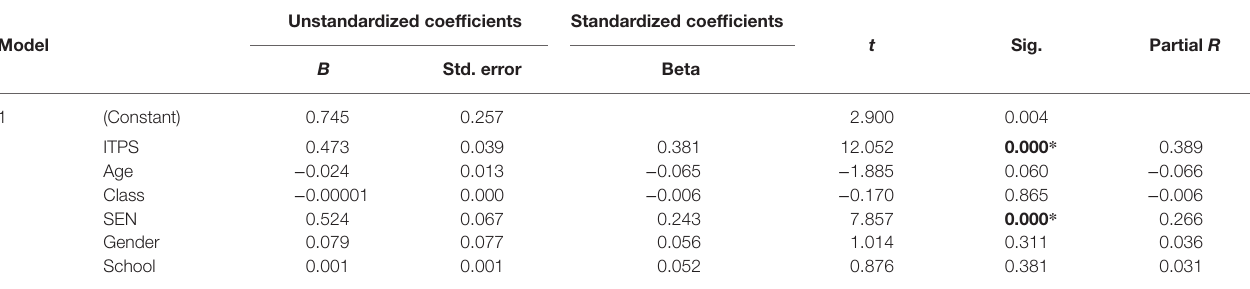
TABLE 5 | Multiple regression statistics for examining the predictors of students’ perceived academic self-concept.